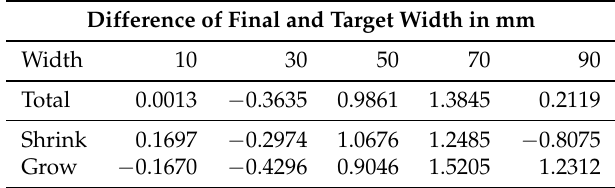
Table 9. Difference from the final mean and target width in mm.